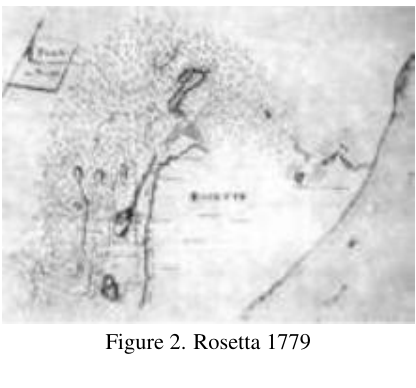
Figure 2. Rosetta